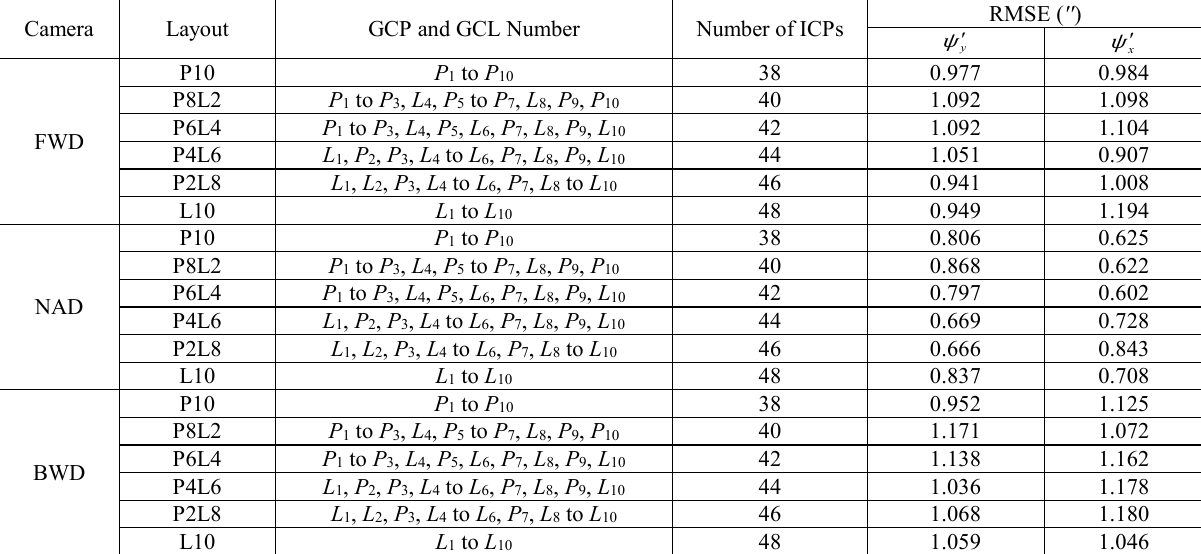
Table 2. Calibration accuracy of the CCD-detector look angles of the ZY-3 TLCs in the dataset